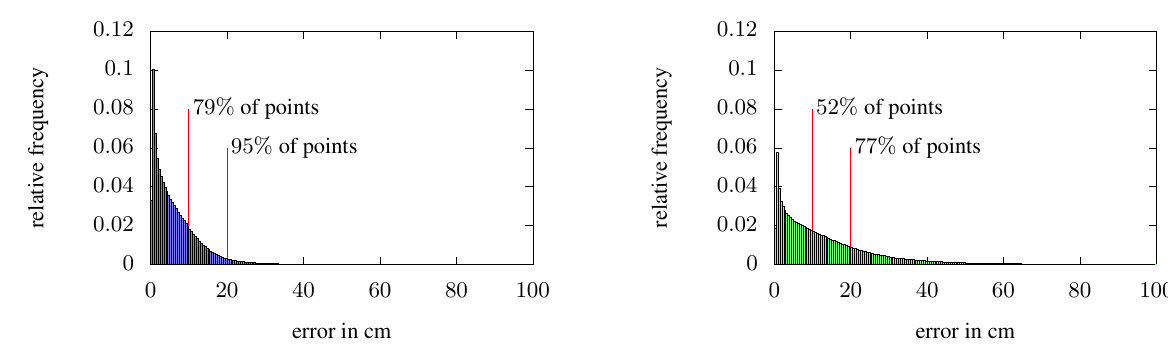
Figure 10. Deviation of dataset Trajectory3D from ground truth. Figure 11. Deviation of dataset Trajectory2D from ground